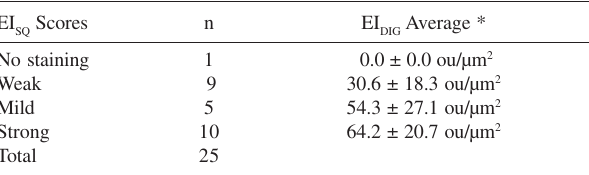
) according to the scores of DIG ) SQ Average * DIG